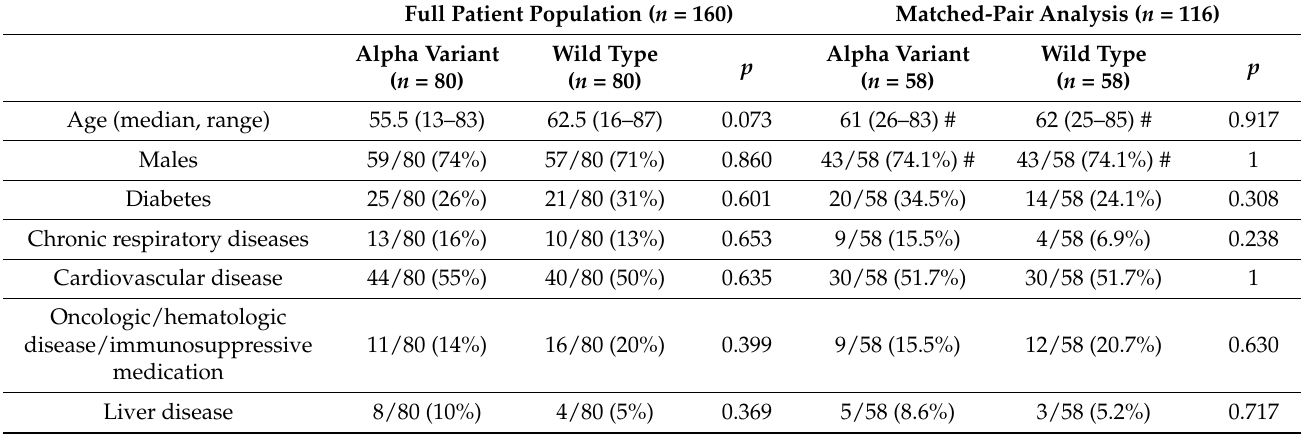
Table 1. Baseline patient characteristics of both the full patient population as well as the matched-pair analysis. No significant differences were identified between the SARS-CoV2 Alpha variant group and the SARS-CoV2 wild-type group. #: matching criteria (sex,